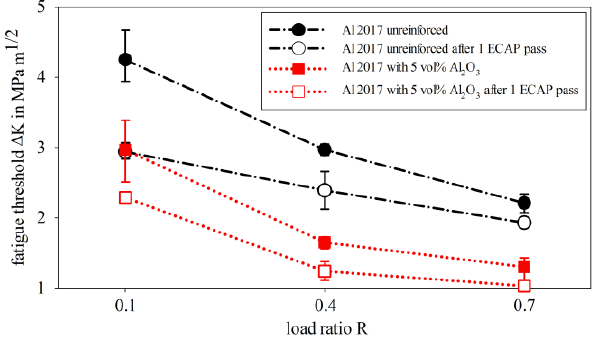
Figure 8. Fatigue thresholds of Al 2017 in unreinforced and reinforced conditions with additional ECAP at different load ratios. The ECAP-processed matrix material exhibits the least dependency on the load ratio. In contrast, the matrix material and the reinforced conditions depend strongly on the load ratio and display almost the same amount for the three